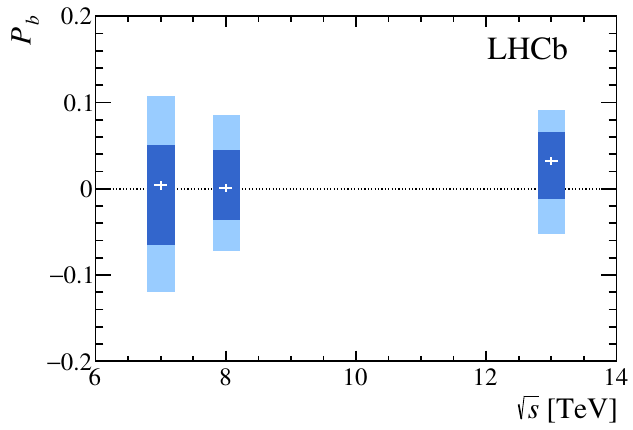
baryons, P b , as a function of the b